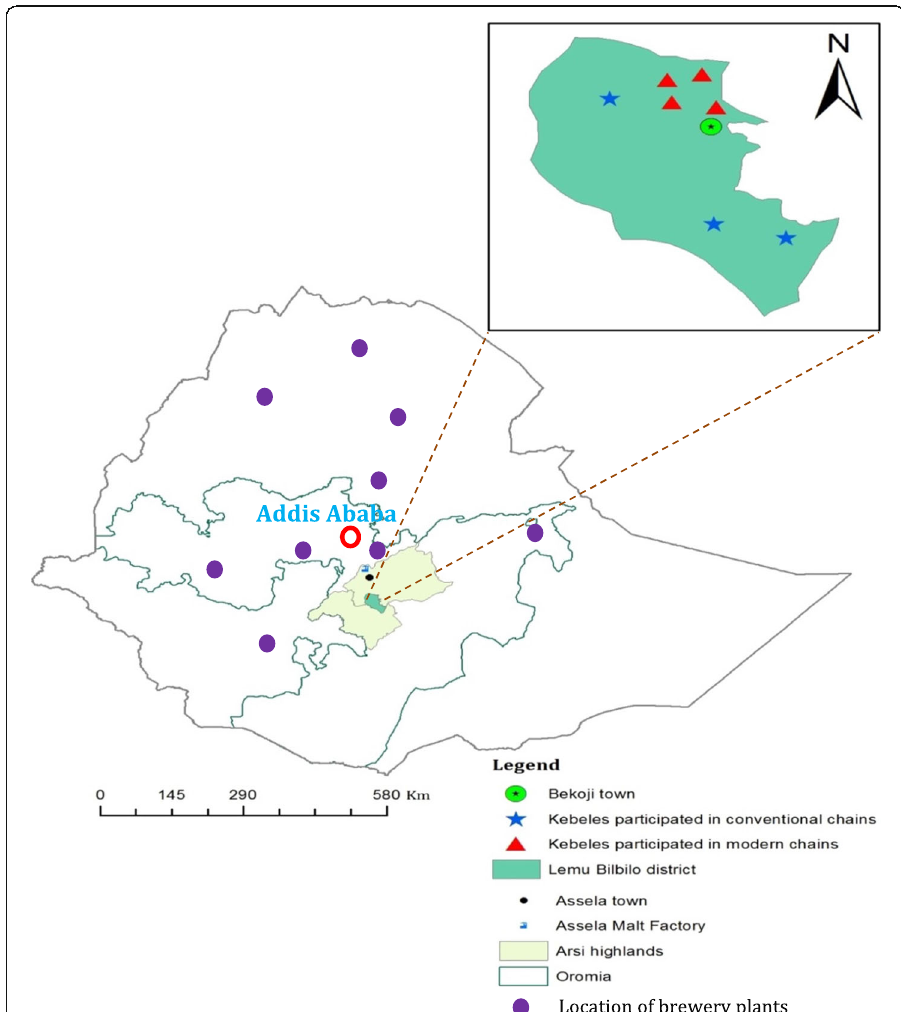
Fig. 1 Location of brewery plants in Ethiopia and research